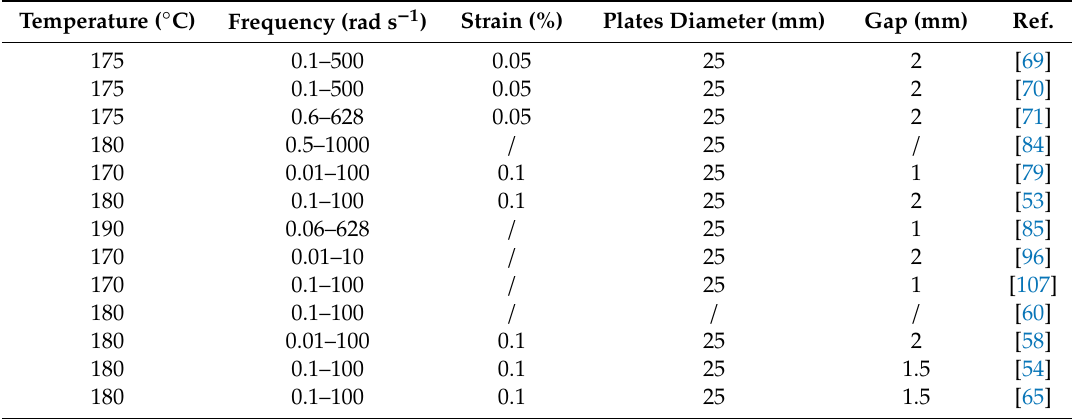
Table 6. Formulations tested with rotational